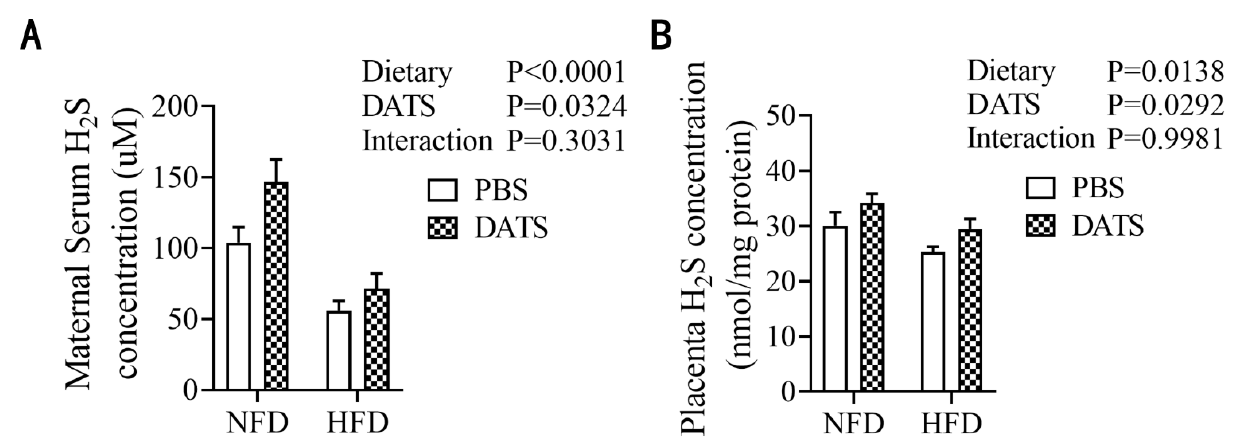
Figure 1. DATS treatment can increase the content of hydrogen sulfide in obese mice during preg-